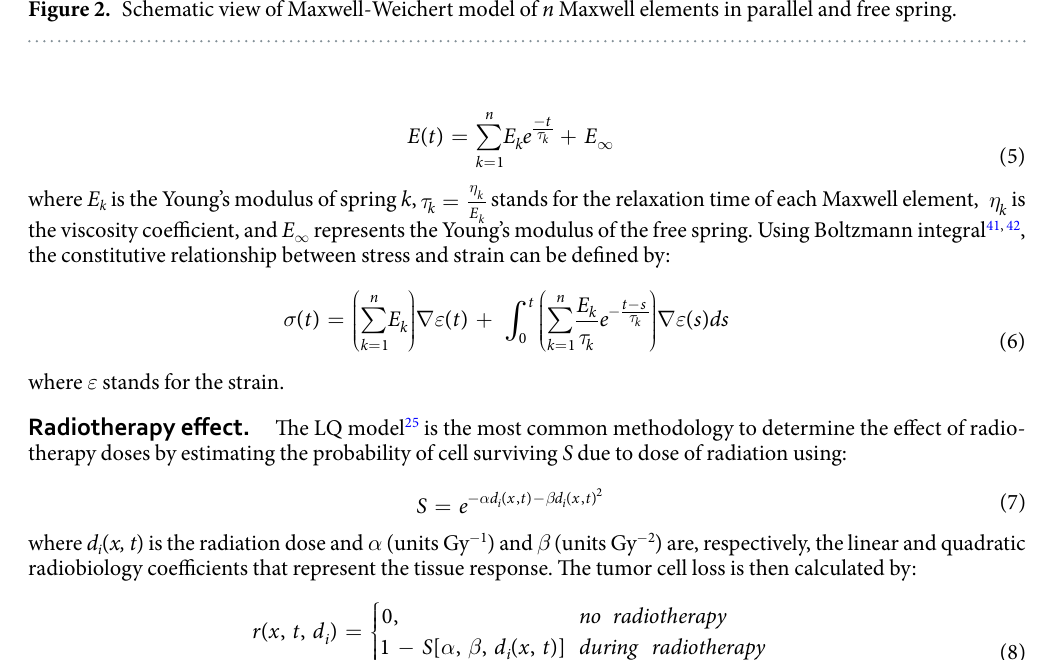
Figure 2. Schematic view of Maxwell-Weichert model of n Maxwell elements in parallel and free